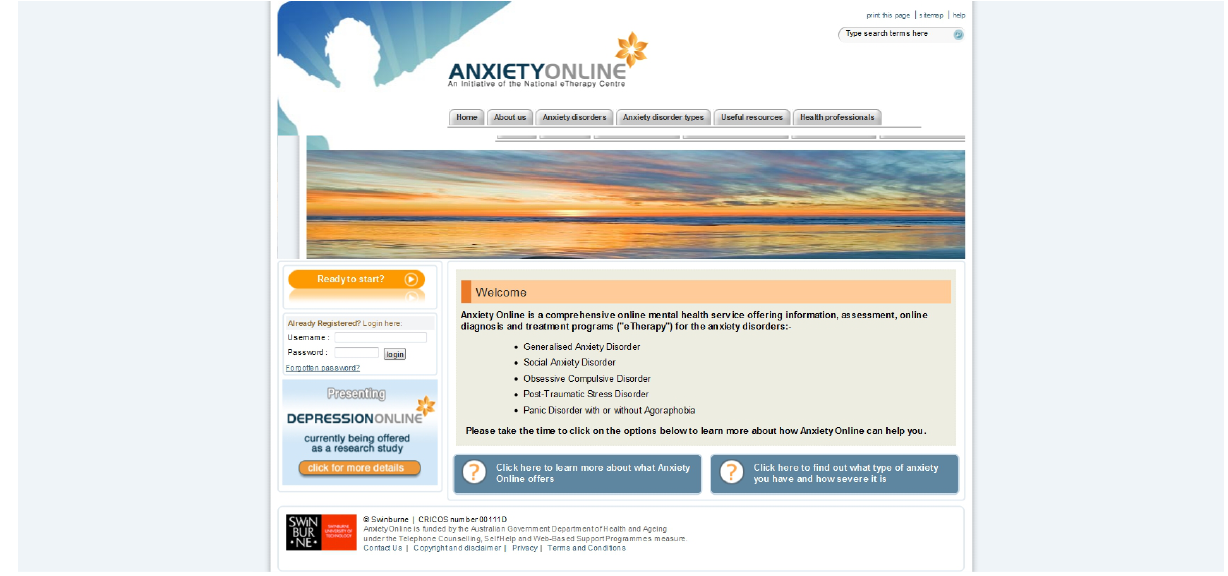
Figure 1. Anxiety Online homepage